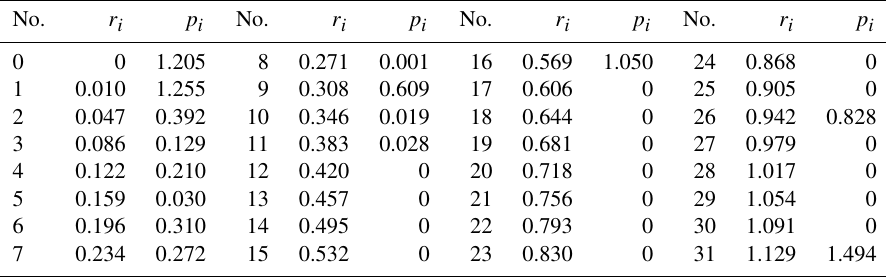
Table 1. Identified parameters of the Prandtl-Ishlinskii model. No.